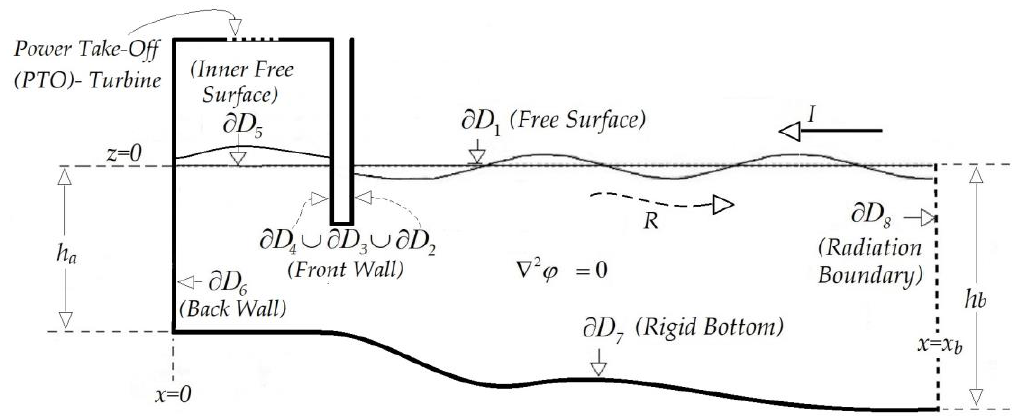
Figure 1. Definition of the Oscillating Water Column (OWC) domain in the variable bathymetry region and the decomposition of the boundary ∂D into eight sections.